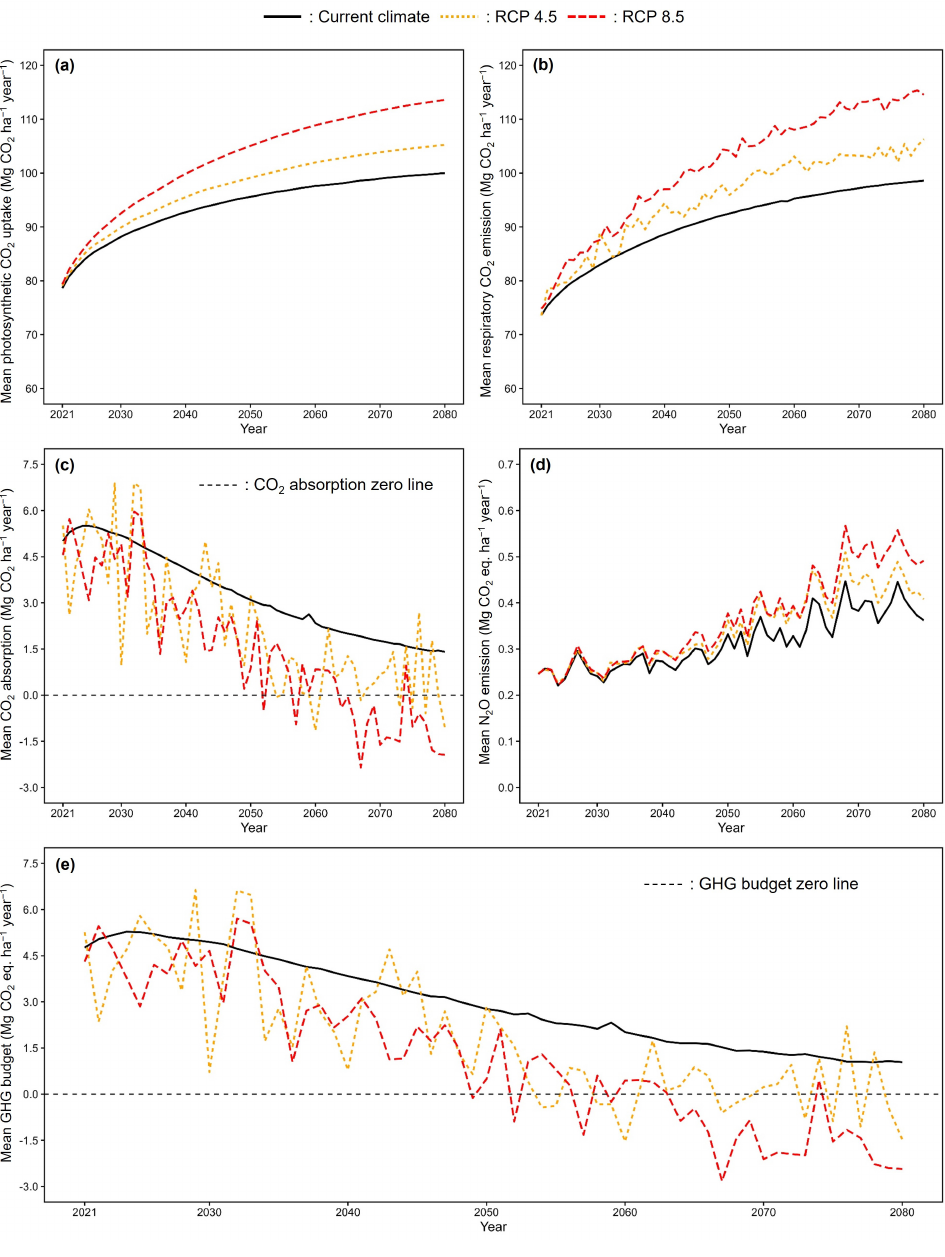
Figure 2. The mean ( a ) photosynthetic CO 2 uptake, ( b ) respiratory CO 2 emissions including both autotrophic and heterotrophic respiration, ( c ) CO 2 absorption, ( d ) N 2 O emissions, and ( e ) greenhouse gas (GHG) budget (the sum of CO 2 absorption and N 2 O emissions) from 2021 to 2080 under the current climate (black solid lines), RCP 4.5 (orange dotted lines), and RCP 8.5 (red dashed